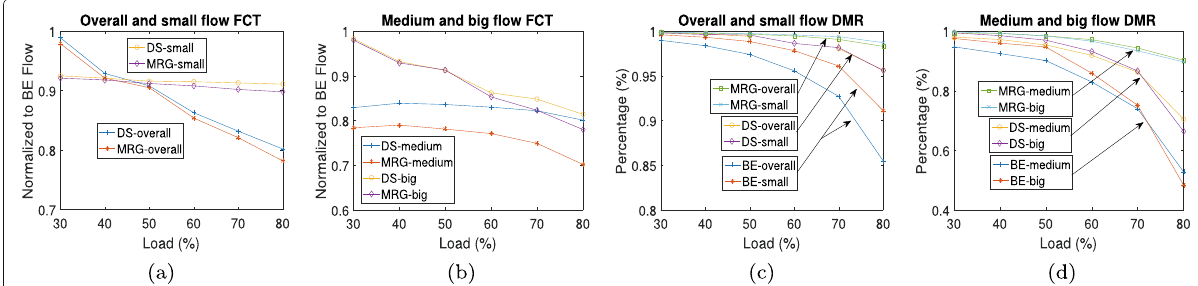
Fig. 11 FBP with Data-ming workload ( a ) overall and small flow FCT; ( b ) Medium and big flow FCT; ( c ) Overall and small flow DMR; and ( d ) Medium and big flow